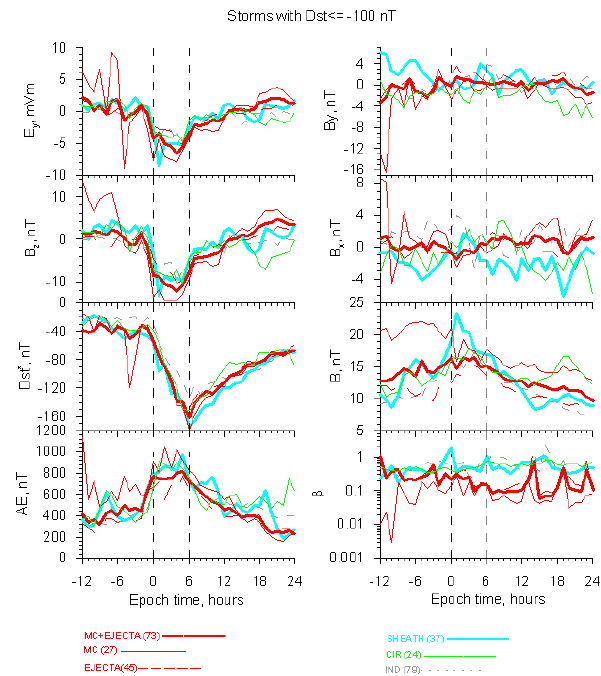
Fig. 6. The same as in Fig.2 for strong storms with Dst < -100 nT. Fig. 4. The same as in Fig.2 for moderate storms with -100 < Dst < -50 nT.